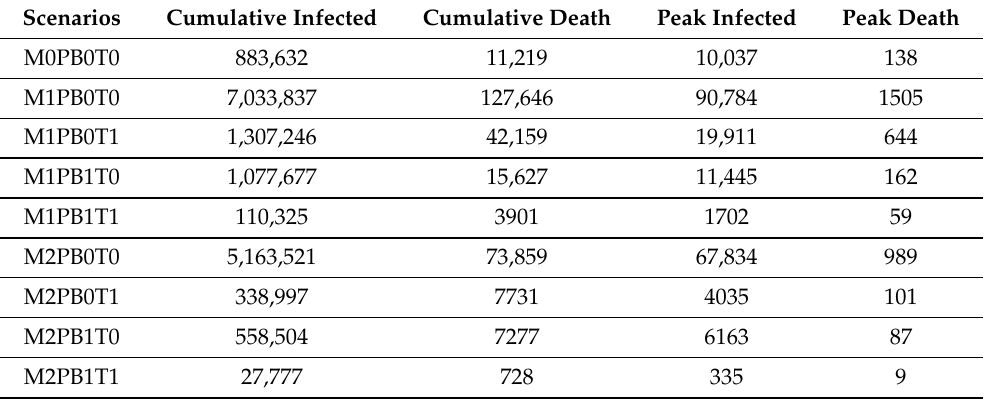
Table 3. Summaries of outcomes for different intervention